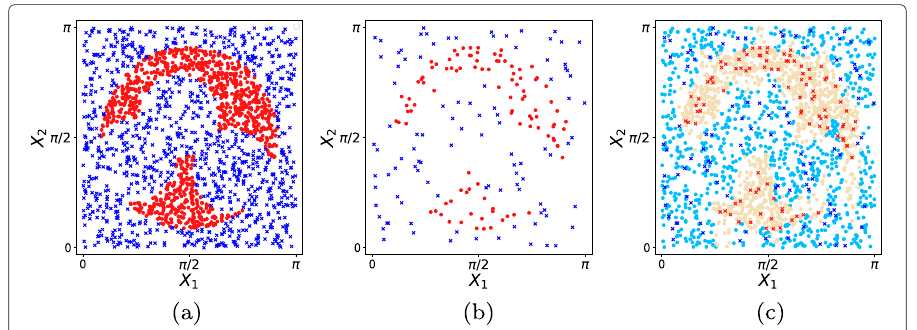
Fig. 4 Classification of randomly generated data: a Training data. In total, we generated 1100 blue points and 1100 red pints by the same generating function. 100 red points and 100 blue points are chosen randomly as training data, and the left pints are used as test data. b Training data including 100 red points are 100 blue points. c Prediction for the labels of test data. Light blue points are test data predicted as ‘blue’, and yellow points are predicted as ‘red’. Red and blue cross represent training